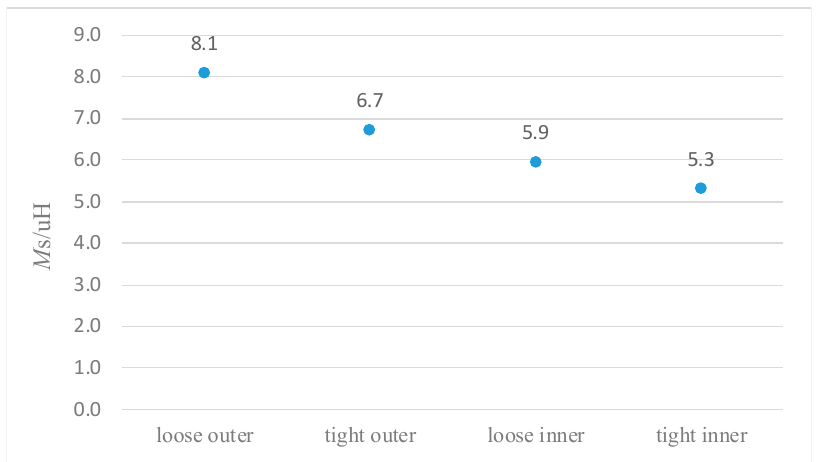
Figure 11. The mutual inductance of the driving coil under four typical arrangements.